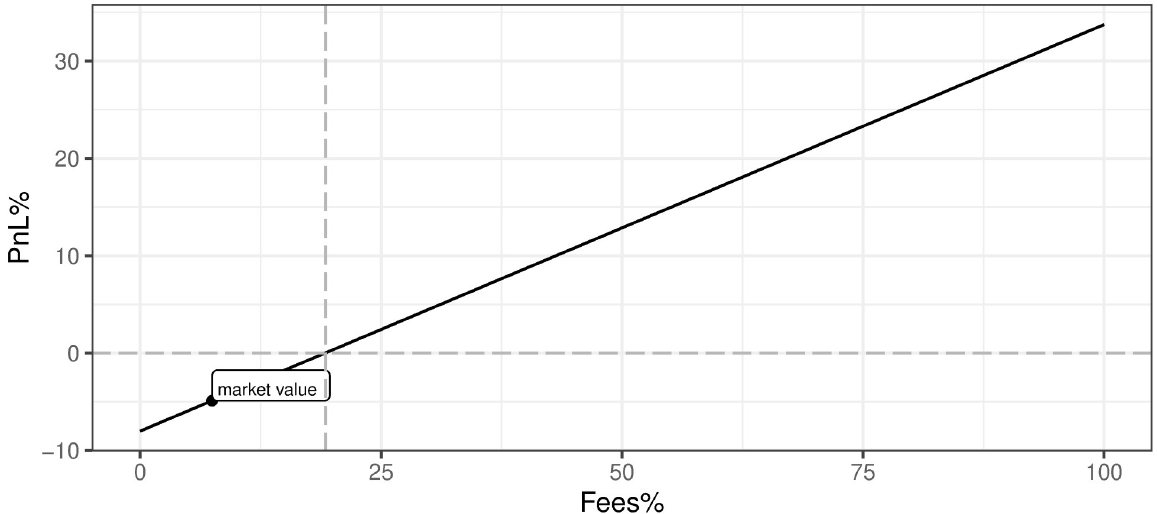
Fig 24. BTC mining profitability (PnL%) for different levels of fees defined as % of BTC mined. Note: PnL%, calculated according to the formula 6. Hypothetical transaction fees range from 0% up to 100% of BTC mined. The market value point describes the current state of market mining efficiency assuming parameters outlined in the section Values of variables as of 2021/12/03. Source: own calculations based on data described in section Crucial assumptions and data.